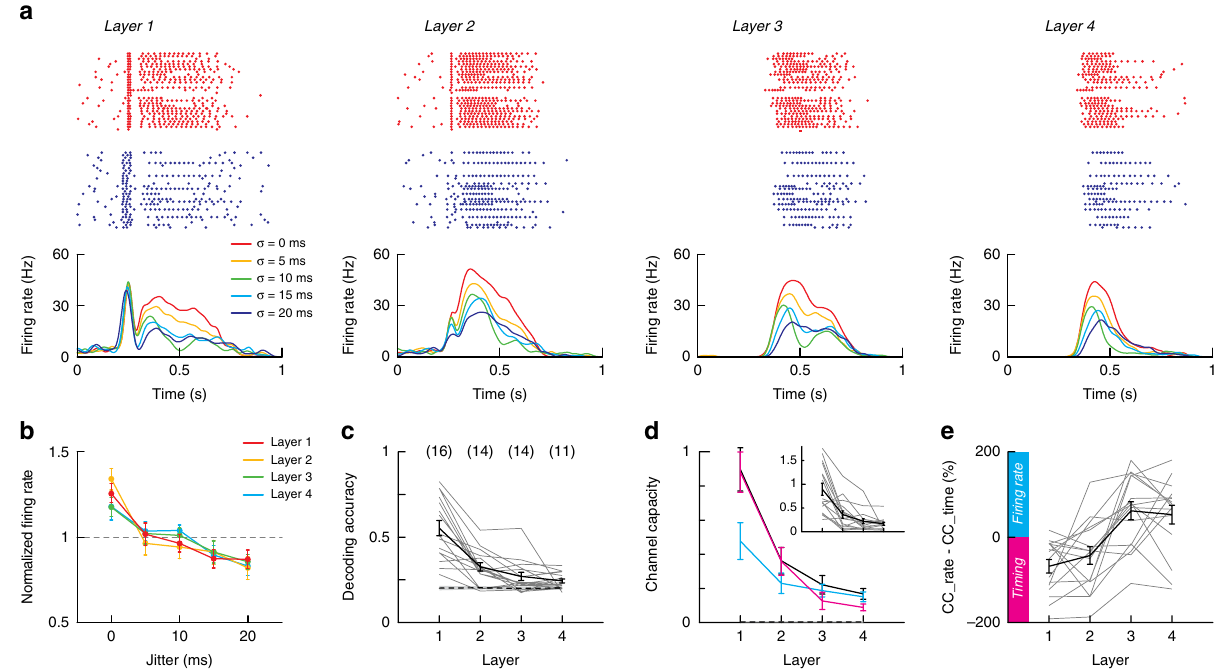
Fig. 4 Propagation of information about the stimulus jitter in multilayer networks. a Top, dot rasters of spiking activity in individual cells in layers 1 – 4 (left to right) for stimulus jitters ( σ ) of 0 (red) and 20 ms (blue). Simultaneous cell-attached recordings were performed from one neuron in each layer. Bottom, PSTHs compiled from the spiking of neurons evoked with varying stimulus jitters ( σ = 0, 5, 10,15, 20 ms; from red to dark blue). b Firing rate as a function of jitter for neurons in layers 1 – 4. The fi ring rate measured in a 300 ms time window following the stimulus was normalized (divided) by the rate averaged over the different jitters. c Decoding accuracy quanti fi ed as the probability of correctly classifying stimulus jitter in each layer. Decoding used time of the fi rst spike and fi ring rate as predictors (see text). Numbers in brackets indicate the number of individual neurons (out of 16 neurons for each layer) with signi fi cant decoding accuracy with a p -value of 0.01 (see Methods). d Channel capacity computed using the time of the fi rst spike and the fi ring rate (black), only the fi ring rate (magenta), or only the time of the fi rst spike (cyan) as predictors. Inset: channel capacity for individual data. e Difference between the information carried by the fi ring rate and the information carried by the time of the fi rst spike relative to their sum. Data are compiled from the same n = 16 dense networks of Fig. 2 and are presented as mean ± SEM. In c – e all data are shown as thin